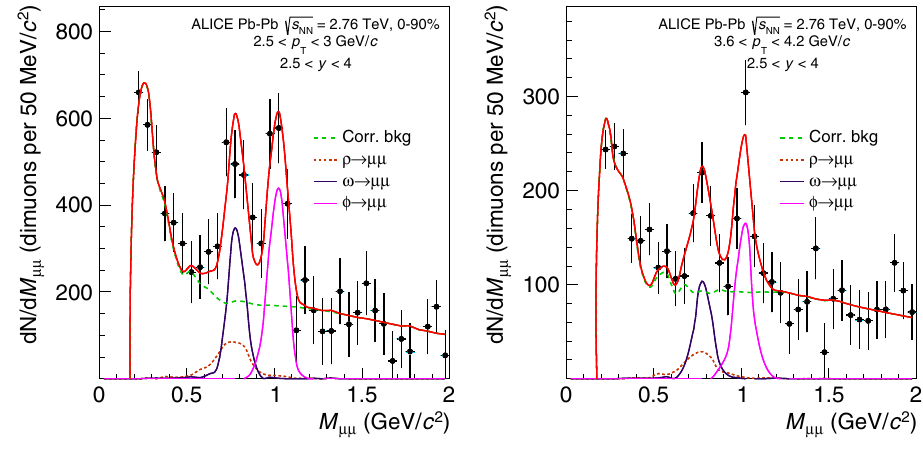
Fig. 4 Invariant mass spectra for 2 . 5 < p T < 3 GeV/c and 3 . 6 < p T < 4 . 2 GeV/c in 0–90% Pb–Pb collisions at √ s NN = 2 . 76 TeV. The solid red